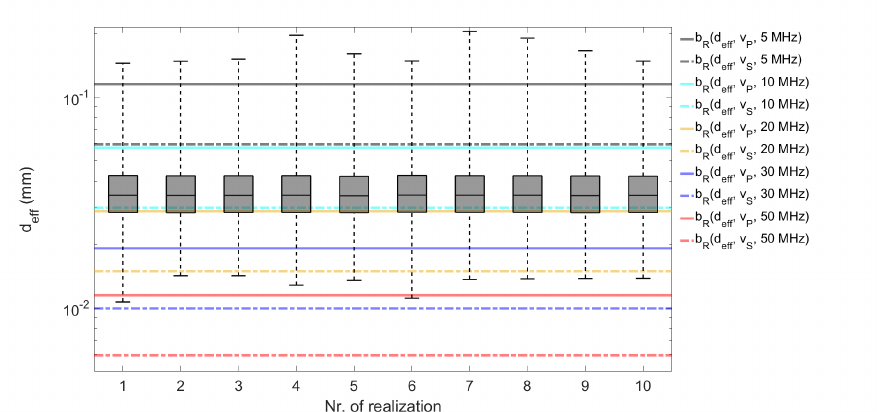
Figure 17. Effective cell diameters in ten realizations of the microstructure model for the titanium. Clearly, the Rayleigh regime is violated in the 50 MHz case.